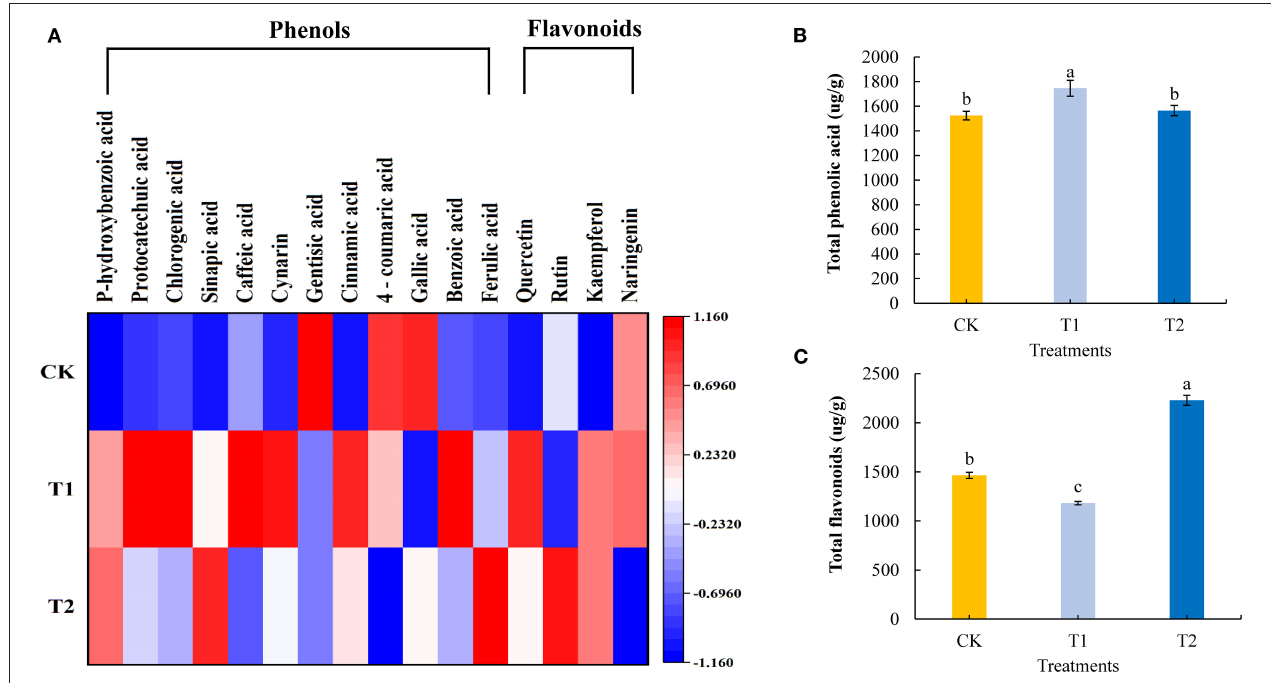
FIGURE 6 | Phenolic acid component and flavonoids component (A) , total phenolic acid (B) , and total flavonoids (C) contents in tomato fruits under different LED supplementary light periods. The data are expressed as average values ± SD ( n = 3). a − c Indicate significant differences between treatments ( P < 0.05, Duncan’s multiple range test). The bars indicate standard errors. CK, no light supplementation control; T1, light supplementation for 3h in the morning; T2, light supplementation for 3h in the evening.